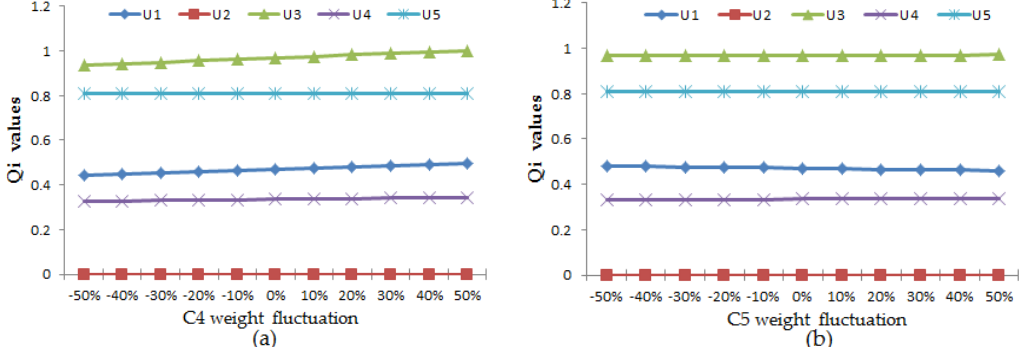
Figure 6. Weight sensitivity analysis for environmental benefits criteria. ( a )Weight sensitivity analysis for sub-criterion C4. ( b )Weight sensitivity analysis for sub-criterion C5.